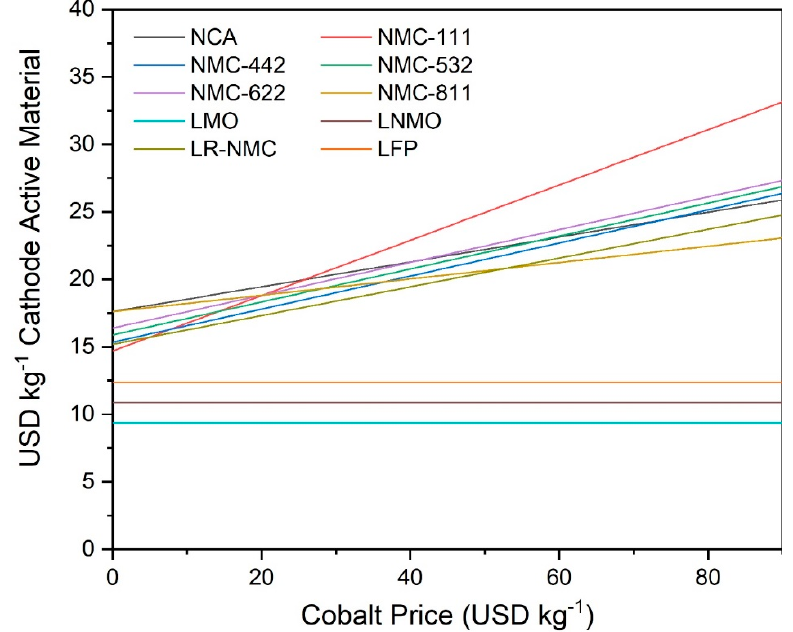
Figure 5. Sensitivity of total manufacturing costs of NCA, NMC-111, NMC-442, NMC-532, NMC-622, NMC-811, LMO, LNMO, LR-NMC, and LFP cathode active materials to market price of cobalt from theoretical range of 0 USD kg − 1 to 90 USD kg − 1 as determined by battery cell and cost model.